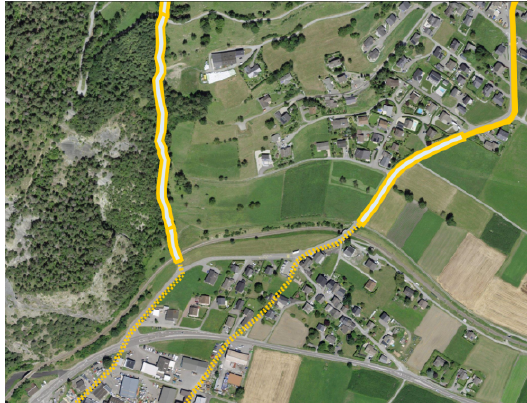
Figure 4. Overview of the Area reserved for water portrayal using the above GeoCSS encoding for GeoServer tiling of data sets, for a long time the existing WMTS stand- ard has been largely used, but a standard for vector tiling has never been established up to now. A possible explanation for this lack of standardization is on the one hand the complex-